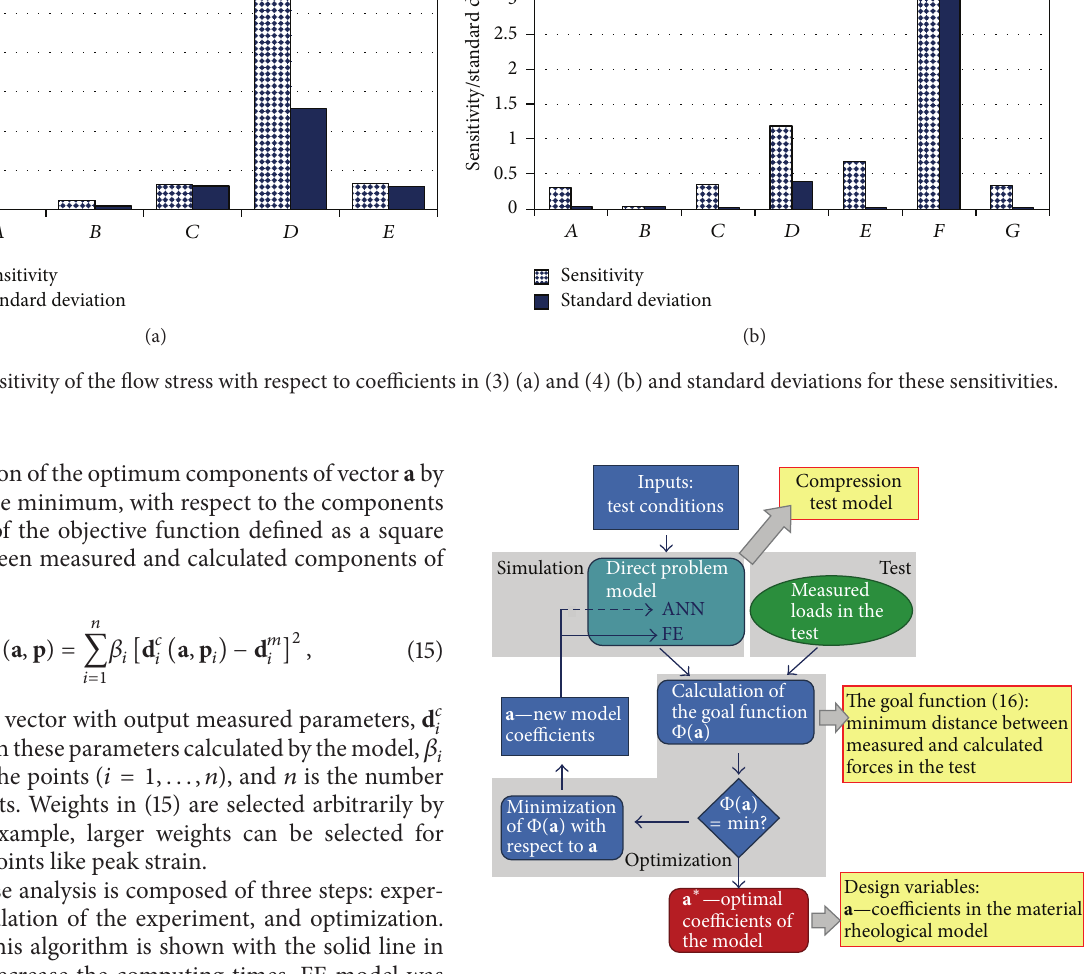
Figure 10: Flow chart of the inverse algorithm with the FE model (solid line) and the metamodel (broken